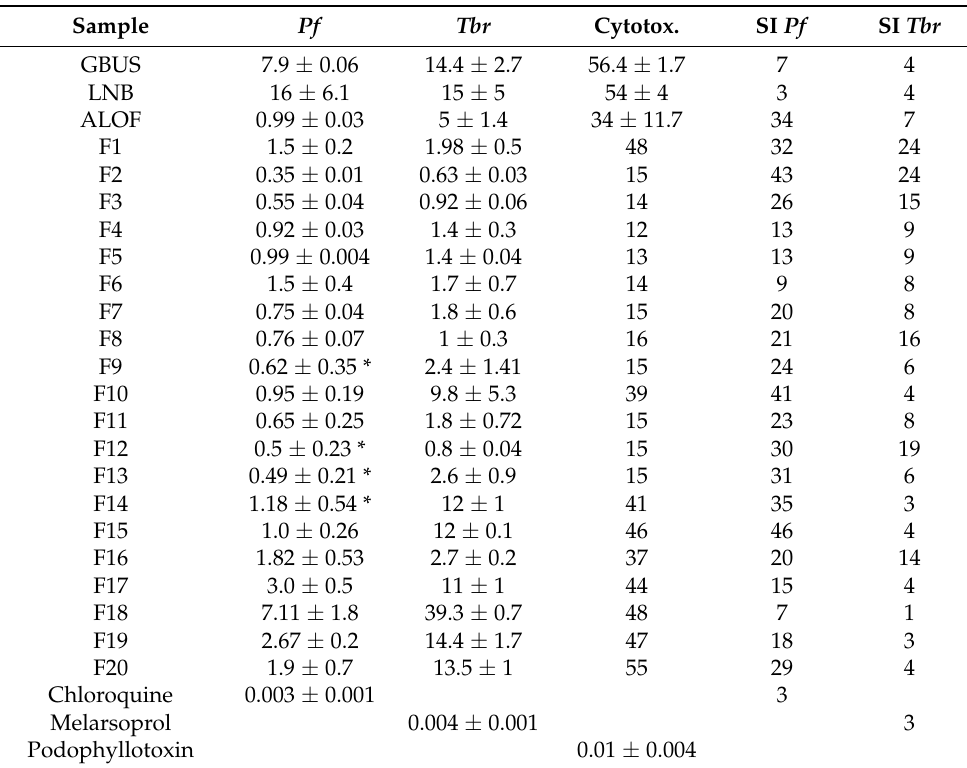
GBUS: crude dichloromethane extract of B . sempervirens L. leaves; LNB: lipophilic and neutral fraction; ALOF: alkaloid fraction; SI: selectivity index. All IC 50 values are expressed in µ g/mL. While * n = 3 was reported as